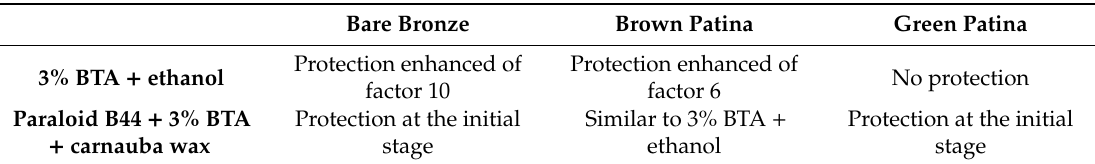
Table 3. Results of impedance measurements from Kosec et al. [27]. The enhancement of the protection refers to the comparison with untreated samples.